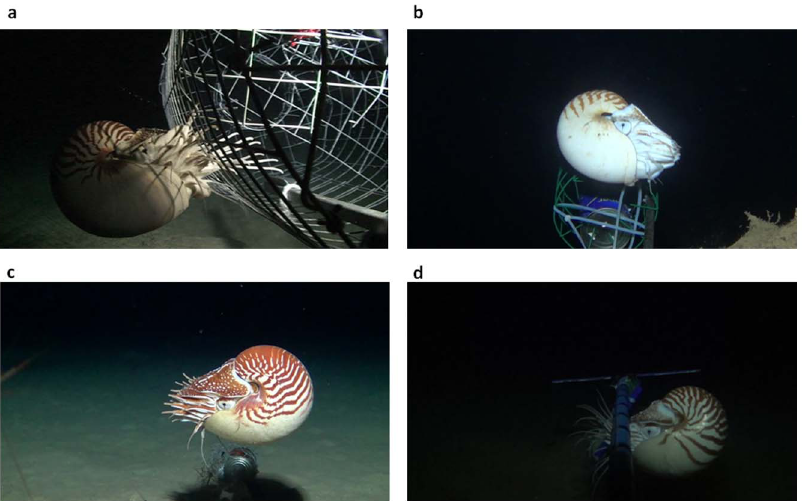
Figure 1. a–d. Photographic identification of nautiluses at each location. Photographs of nautiluses taken from the underwater video footage from Australia (1a), Fiji (1b), American Samoa (1c), and the Philippines (1d).